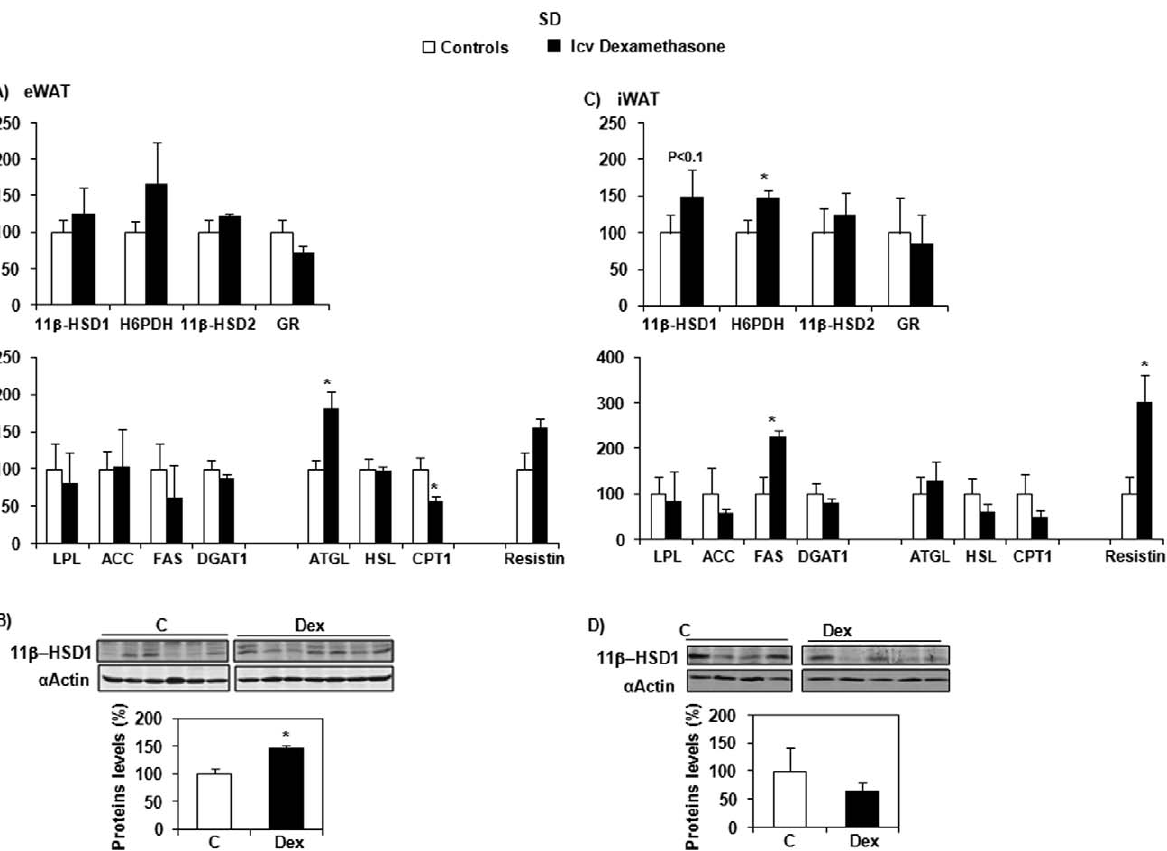
Figure 4. mRNA and protein expression of different markers of GC and lipid metabolism in SD rats. Effects of central (icv) dexamethasone infusion for 2 days in epididymal (eWAT) and inguinal (iWAT) adipose tissue. A and C) Results are expressed as percent of relative mRNA expression compared to that obtained in control rats (100%). The analysis was performed in duplicate and the results are normalized with RPS29 expression. Mean 6 SEM of n =7–8 rats per group. * P , 0.05 compared to vehicle-infused control rats (Student’s t test). B and D) Representative Western blots of 11 b -HSD1 (n=6–7 per group). Quantification was performed using the ChemiDoc TM XRS and the Quantity One TM software. * P , 0.05 compared to vehicle-infused control rats (Student’s t